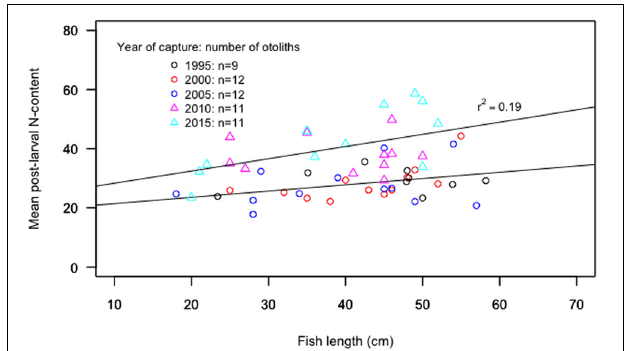
FIGURE 6 | The mean value of the post-larval N-content per otolith in relation to fish length (cm) for all sampled cod. There is a significant increase in mean